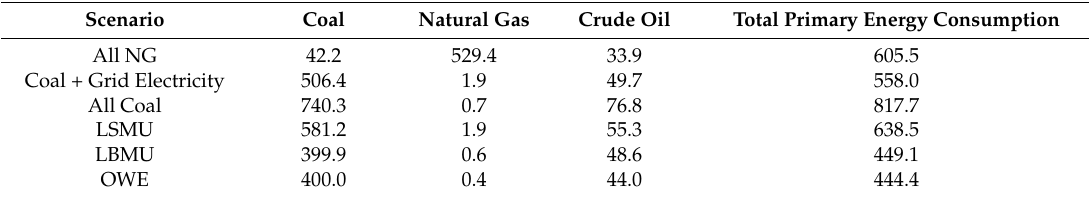
Table 8. Annual primary energy consumption for the studied case in different scenarios (Unit: 10 6 MJ).